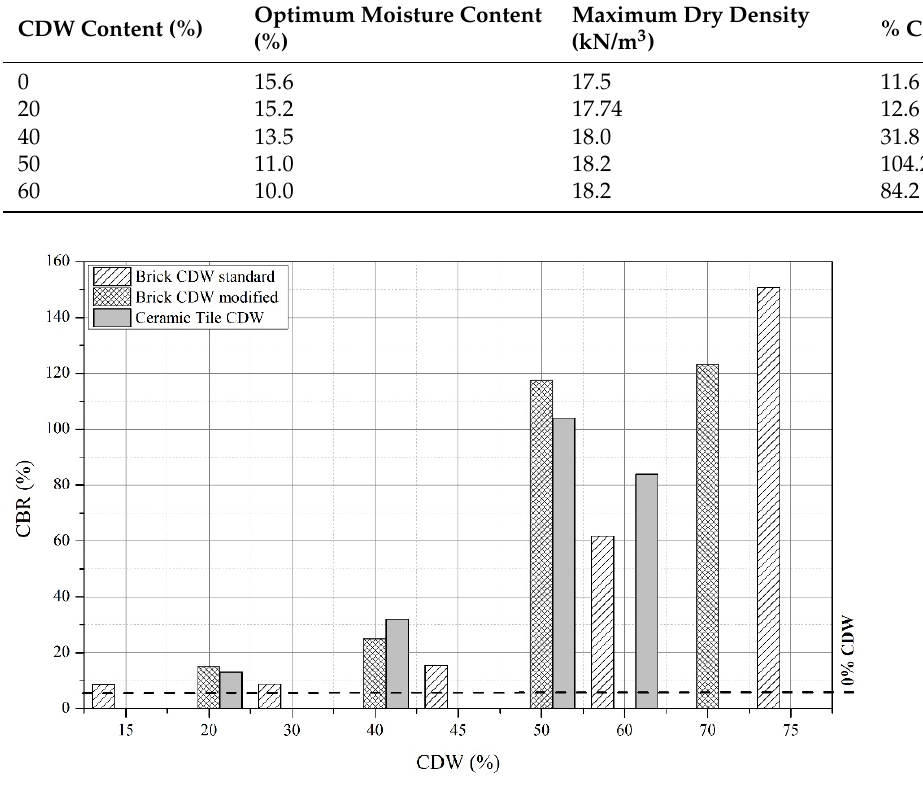
Figure 9. Influence of CDW on the% CBR of the soil. Table 5. CBR Results with normal Proctor energy in soil mixes with brick CDW.